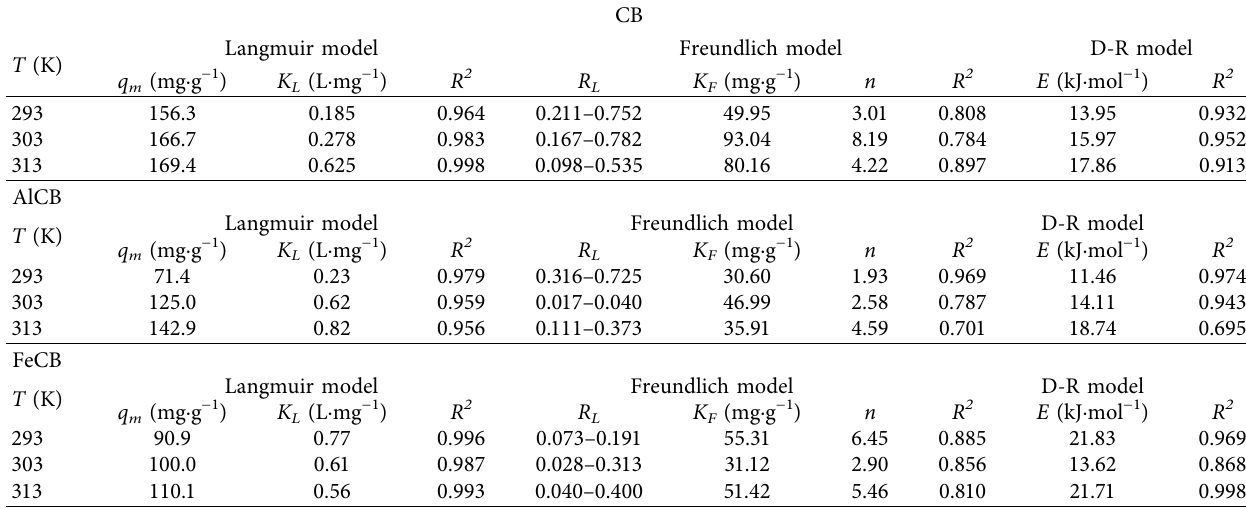
Table 3: The parameters of isotherm models in linear form for the adsorption of phenol red onto the modified bentonite.